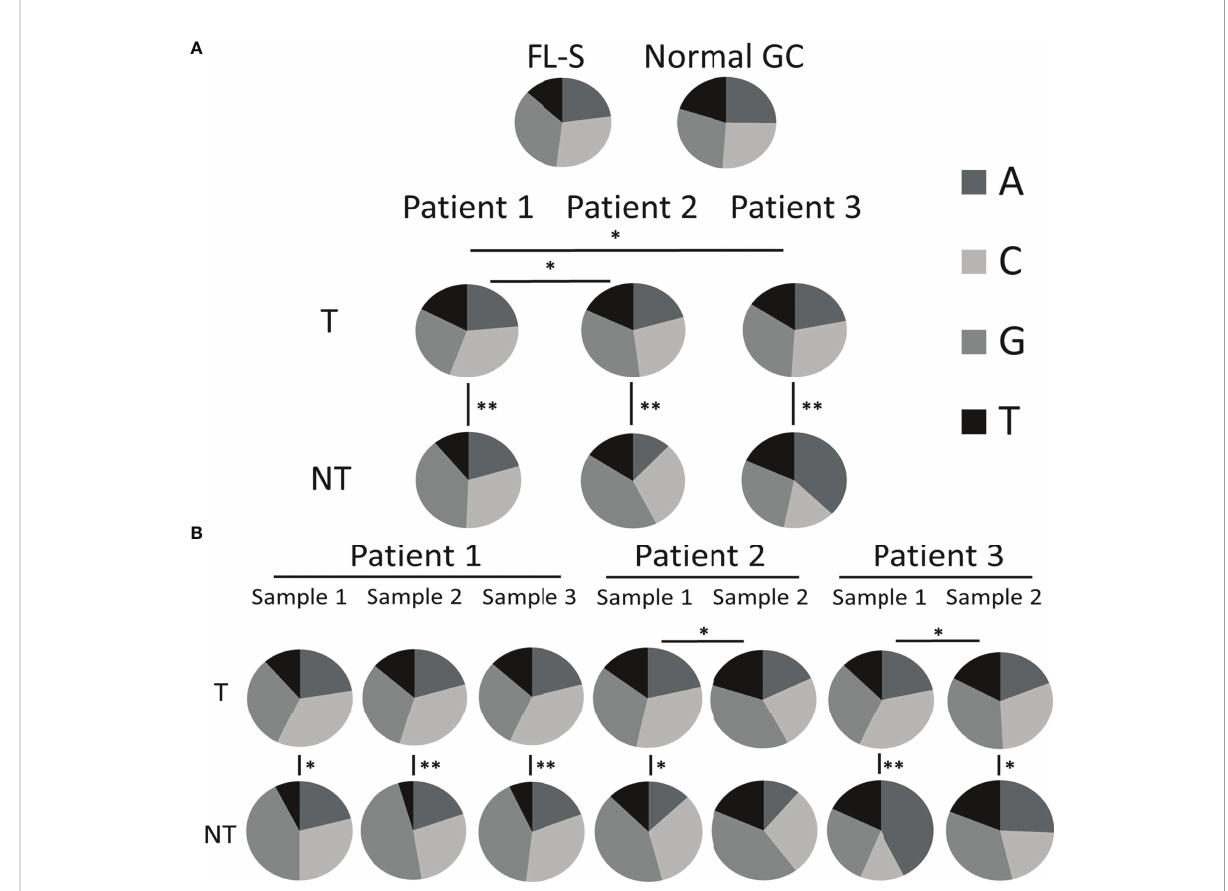
FIGURE 1 Mutation spectra (distribution among nucleotides). The number of mutations from each nucleotide, presented as a fraction out of the total number of mutations, for (A) tumor and non-tumor clones in each patient analyzed (also including the reference FL samples from a previous study and control GC samples) and (B) for tumor and non-tumor clones in each sample analyzed. Signi fi cant differences are indicated with lines between pie-charts (*p-value < 0.05; **p-value < 0.0005). Data regarding the numbers of mutations from each nucleotide and p-values of the comparisons between the different groups are shown in Tables S3, S4 and Tables S5, S6,